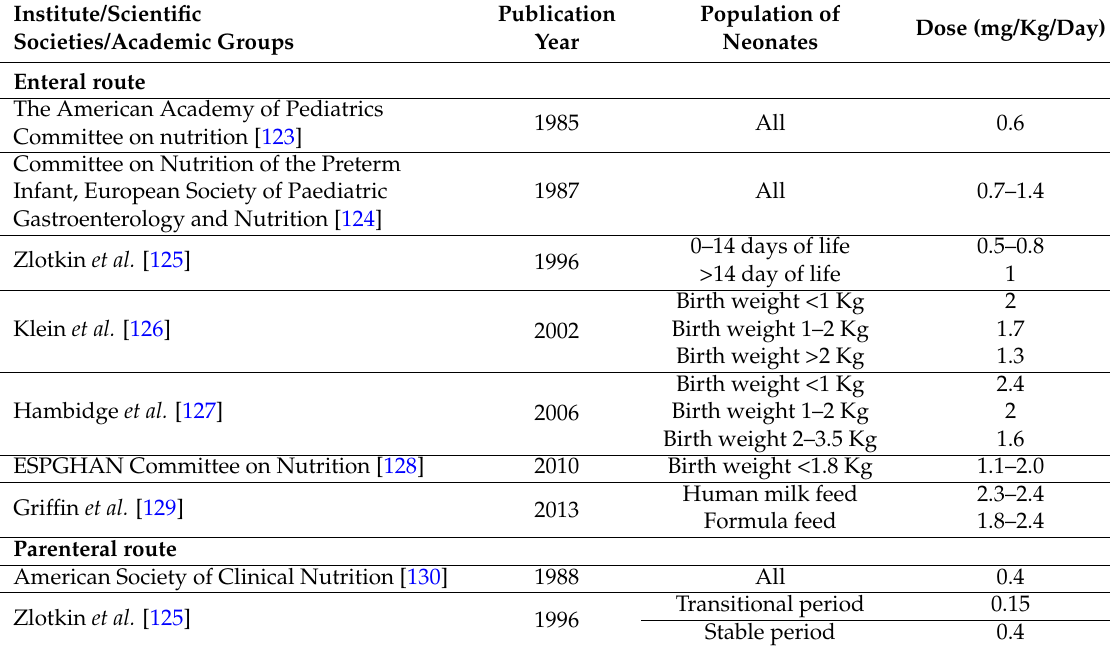
Table 7. Recommendations for zinc in neonates by enteral or parenteral